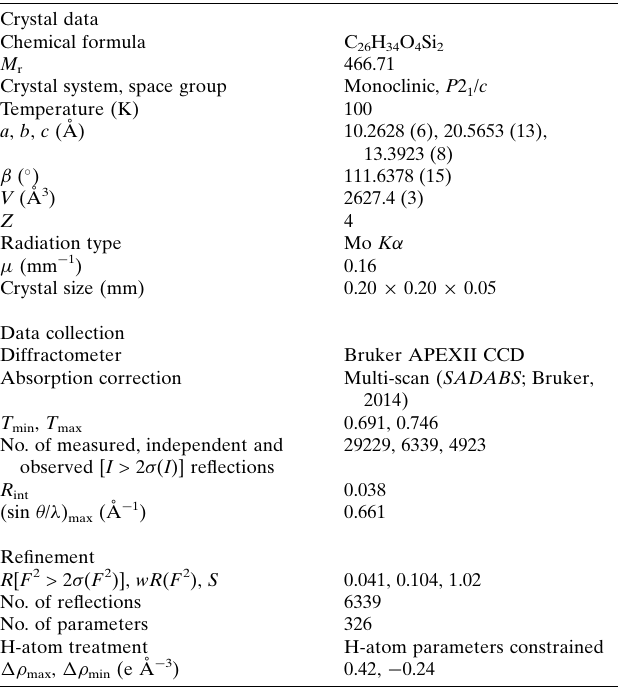
Crystal data Chemical